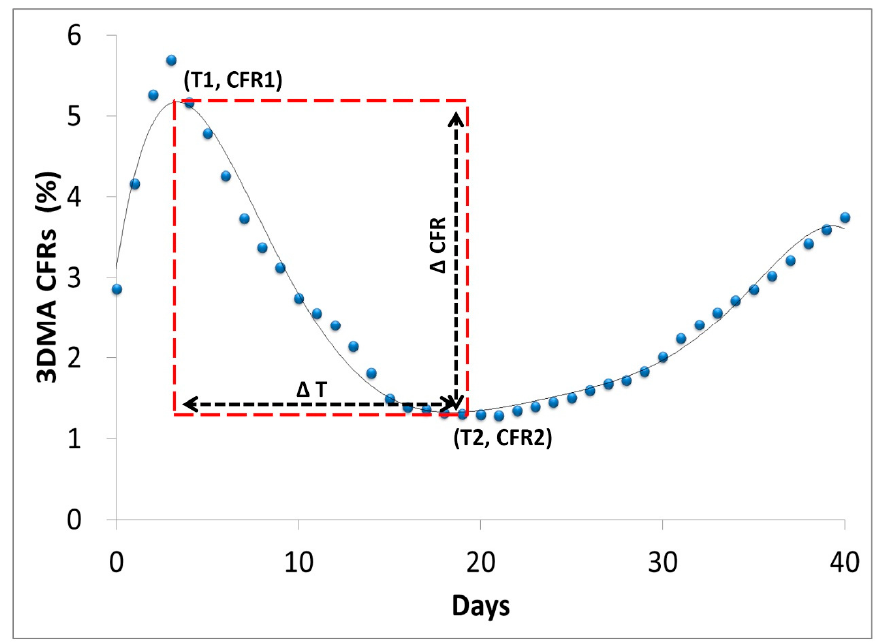
Figure 2. Quantitative characterization of falling zone within common national fitting CFR curve of COVID-19 epidemics.